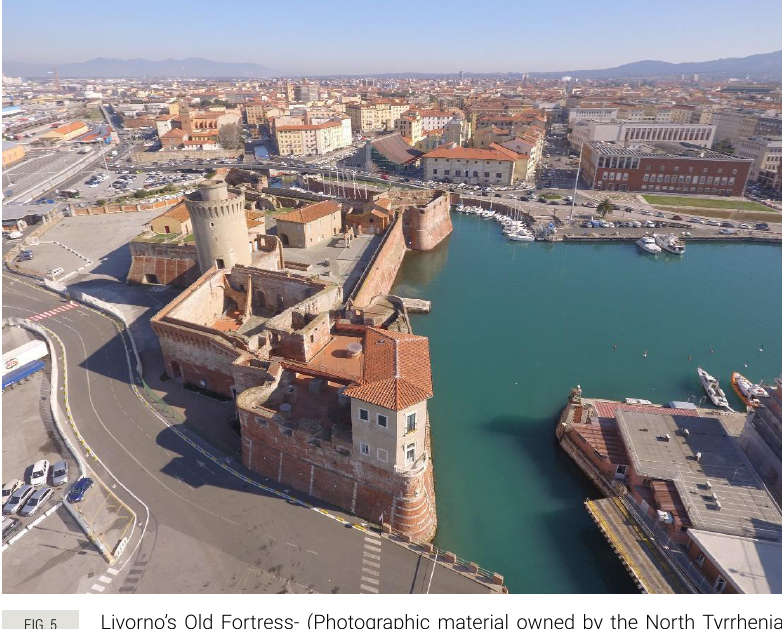
FIG. 5 Livorno’s Old Fortress- (Photographic material owned by the North Tyrrhenian Port Network